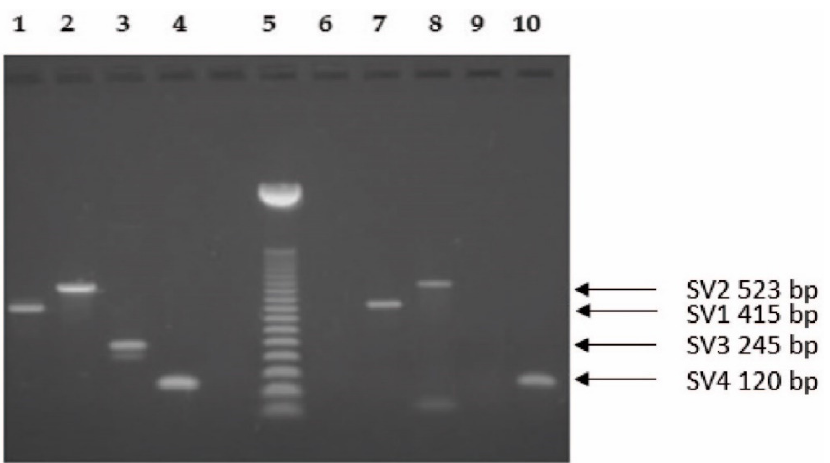
Figure 1. Representative RT-PCR analysis of the splice variants of GHRH receptor in a human pitu- itary sample used as a positive control for PCR (lanes 1–4) and in an endometrium carcinoma sample from patient 29 (lanes 7–10). Lane 5, 50-bp DNA Step Ladder. PCR products were of the expected sizes: SV1 415-bp, SV2 523-bp, SV3 245-bp (present only in the pituitary) and SV4 120-bp long. PCR products were separated by agarose gel electrophoresis and stained with ethidium bromide. Lane 6: negative template control.